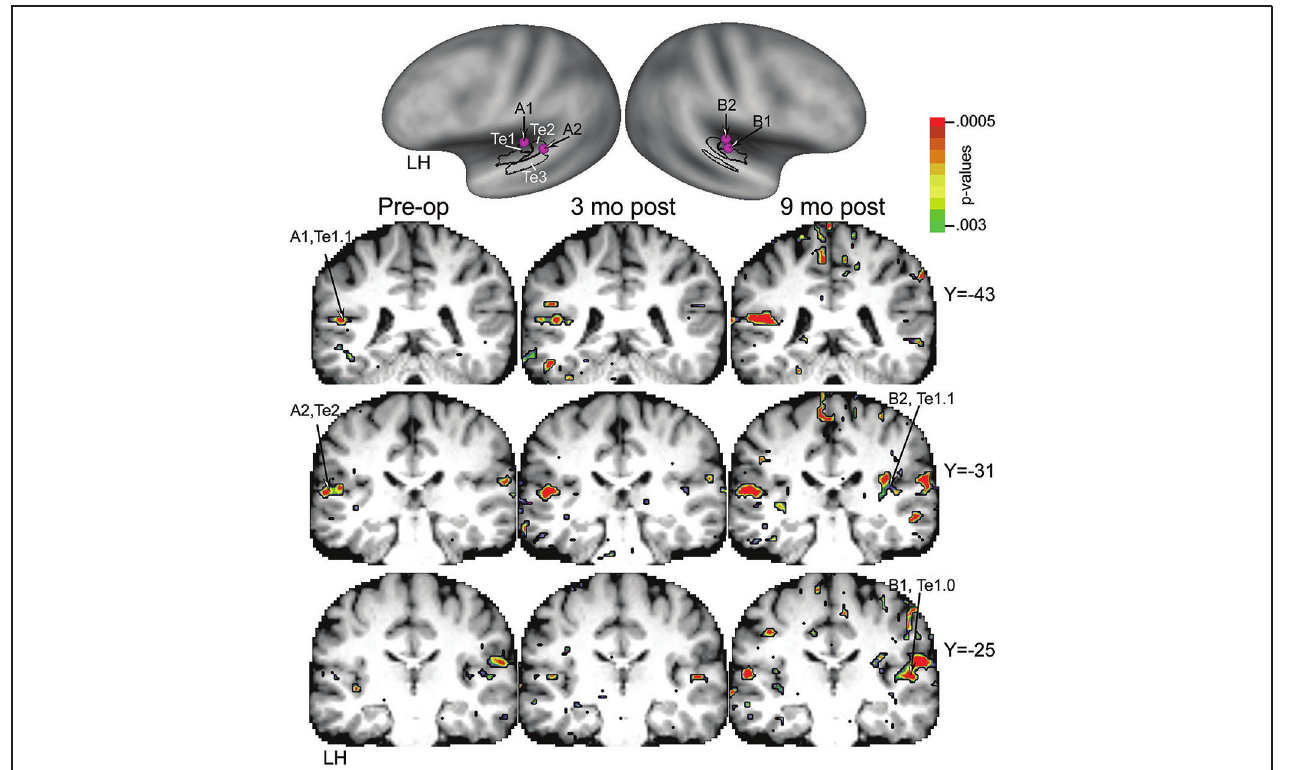
FIGURE 7 | Top row shows superior temporal plane on inflated left and right hemispheres . Black borders indicate the schematic position of auditory cortical fields Te1 to Te3. Labeled purple spheres are placed over cortical surface location of peak F - Z stats in activated cortex. Bottom columns of coronal slices through P1’s structural brain images at the level of the superior